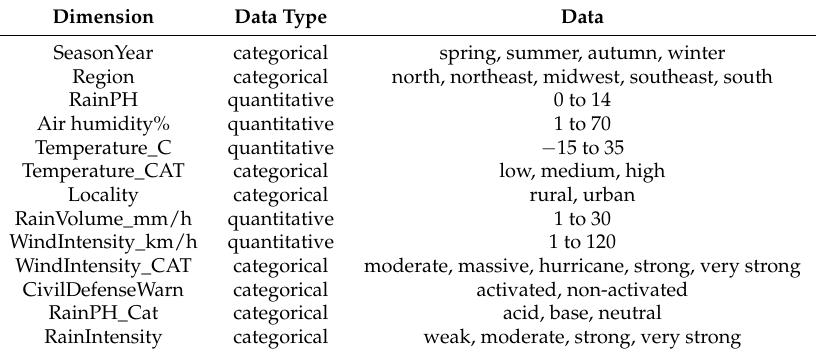
Table 2. Dimensions of the synthetic weather